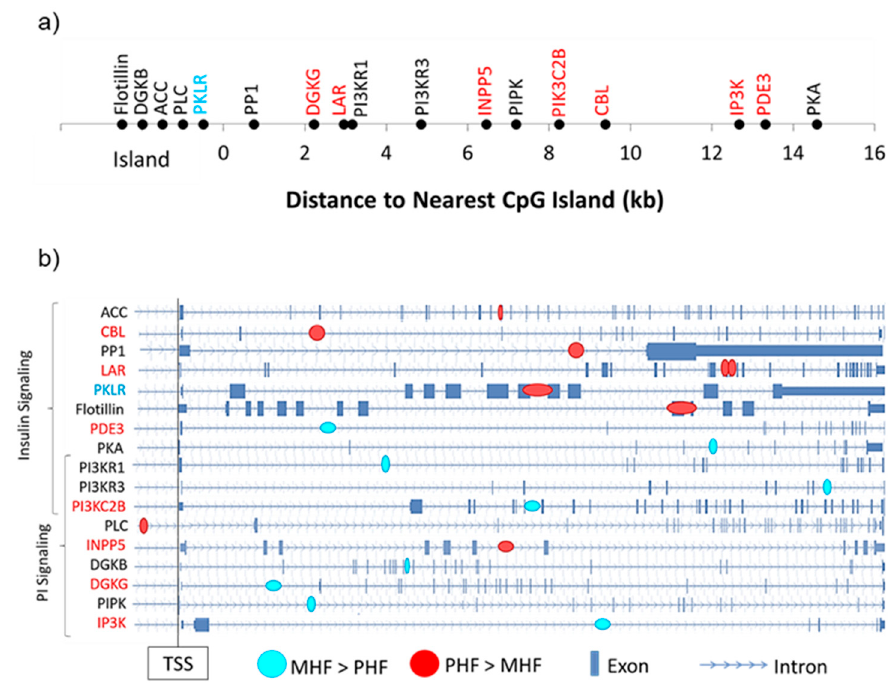
Figure 6. Genomic context of DMRs. ( a ) DMGs within the PI and insulin signaling pathways were mapped according to their distance from the nearest CpG island. Gene names in red and blue denote those that were more highly expressed in the PHF and MHF group, respectively. ( b ) Intragenic DMR position is shown for each DMG in the PI and insulin signaling pathways. Blue circles represent DMRs in which DNA methylation was higher in the MHF group. Red circles represent DMRs in which DNA methylation was higher in the PHF group. Gene names in red and blue denote those that were more highly expressed in the PHF and MHF group, respectively.